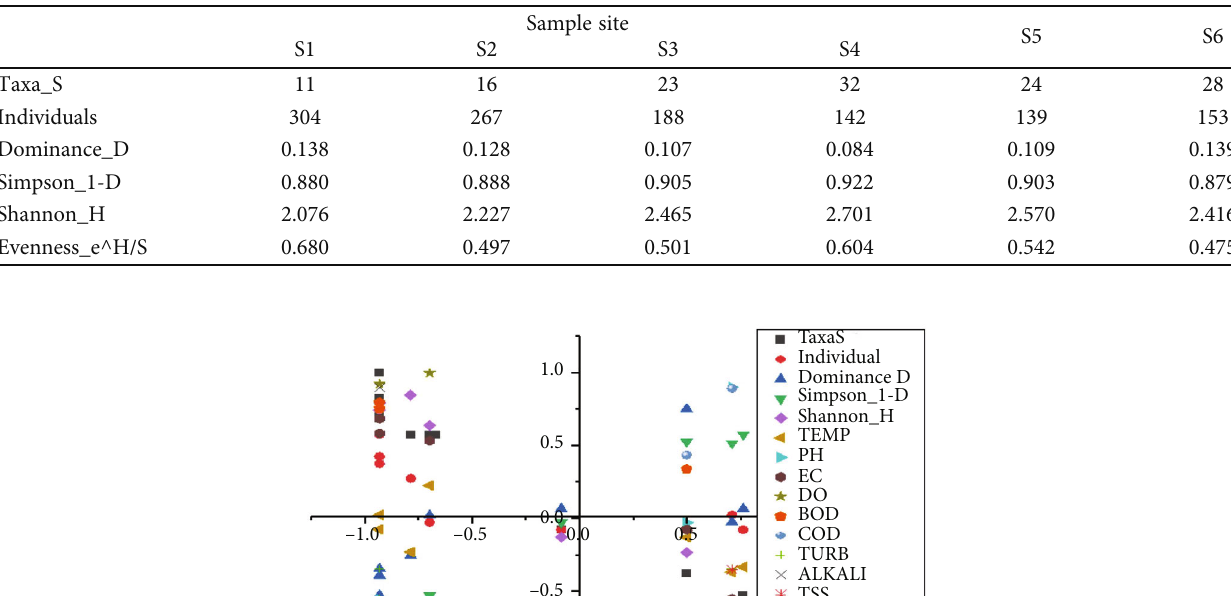
Table 4: Results of bioindices of Awetu River for all sites.